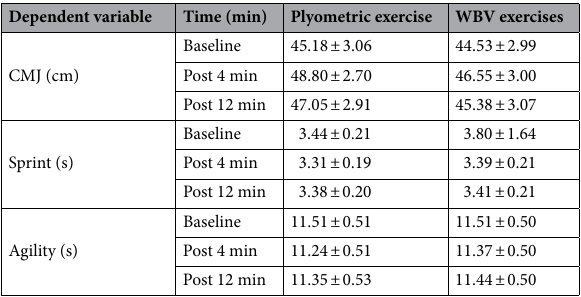
Table 1. Descriptive statistics of dependent variables. N = 24; CMJ countermovement jump, min minute, SD standard deviation.